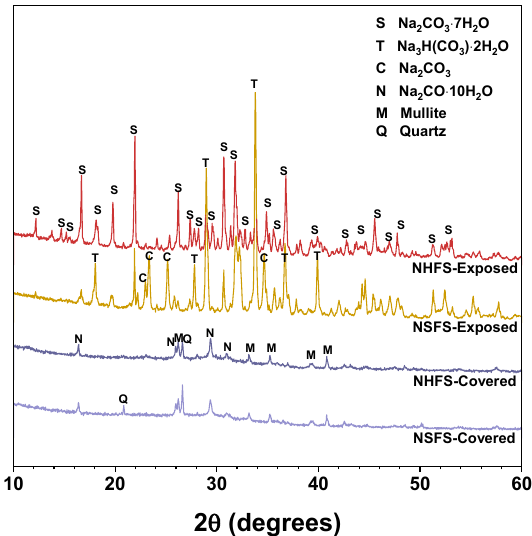
Figure 5. XRD patterns of the efflorescence products scraped from the surface of geopolymer samples. Phases identified: Heptahydrate (S), Na 2 CO 3 · 7H 2 O, PDF No. 76-1108; Trona (T), Na 3 H(CO 3 ) 2 · 2H 2 O, PDF No. 29-1447; Sodium carbonate (C), Na 2 CO 3 , PDF No. 86-302; Natron (N), Na 2 CO 3 · 10H 2 O, PDF No. 15-800; Mullite (M), Al 5.65 Si 0.35 O 9.175 , PDF No. 82-1237; Quartz (Q), SiO 2 , PDF No. 74-1811.